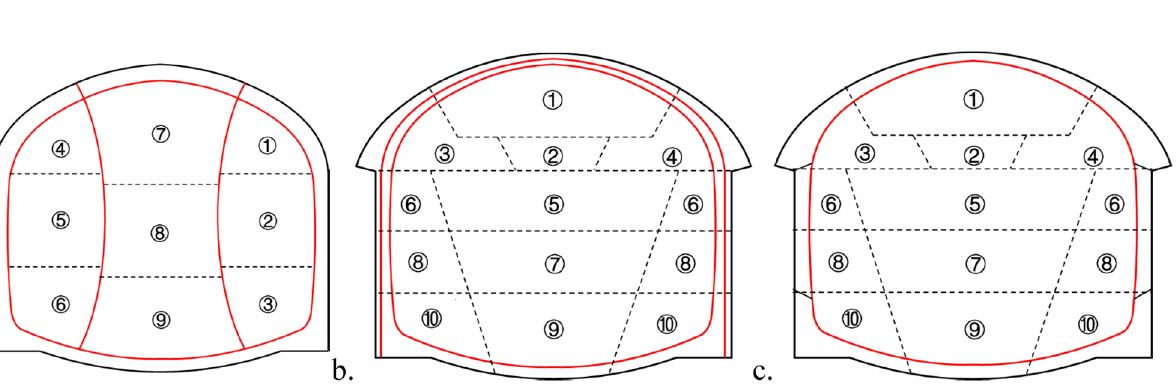
Figure 2. Comparison of the double-side-drift method and arch cover method. ( a ) The double-side-drift method; ( b ) the primary support arch cover method (PCM); ( c ) the secondary lining arch cover method